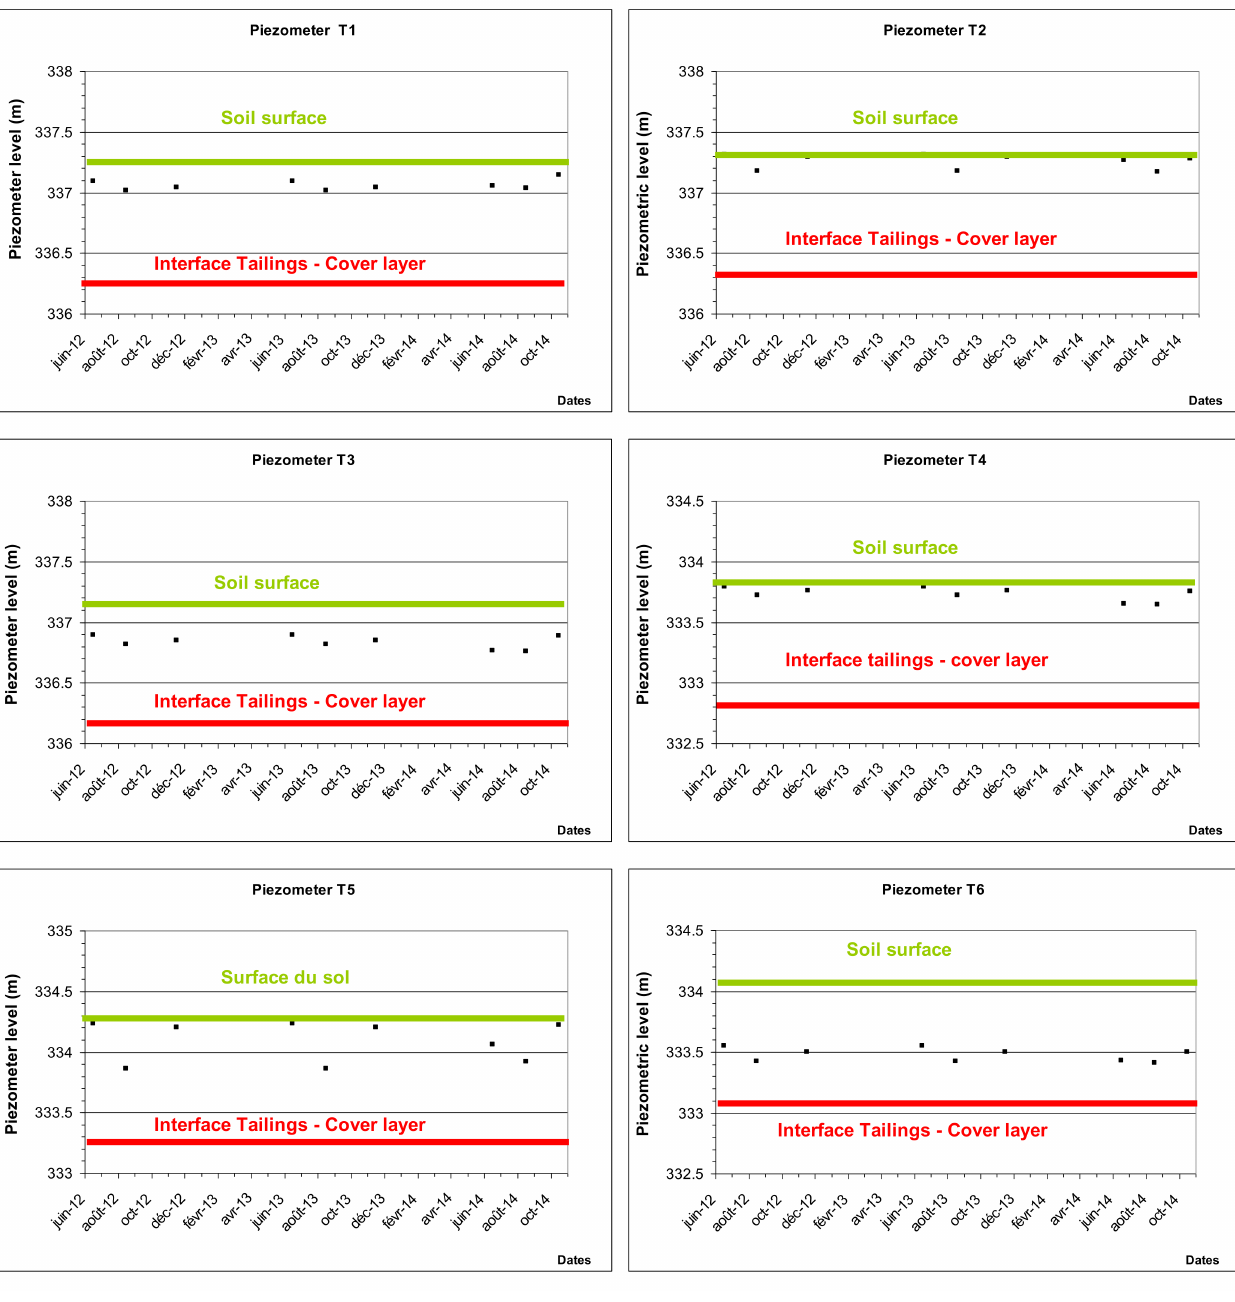
Figure 3. Piezometric level measurements (in meters above sea level—MASL) performed in various observation wells installed in the Aldermac mine